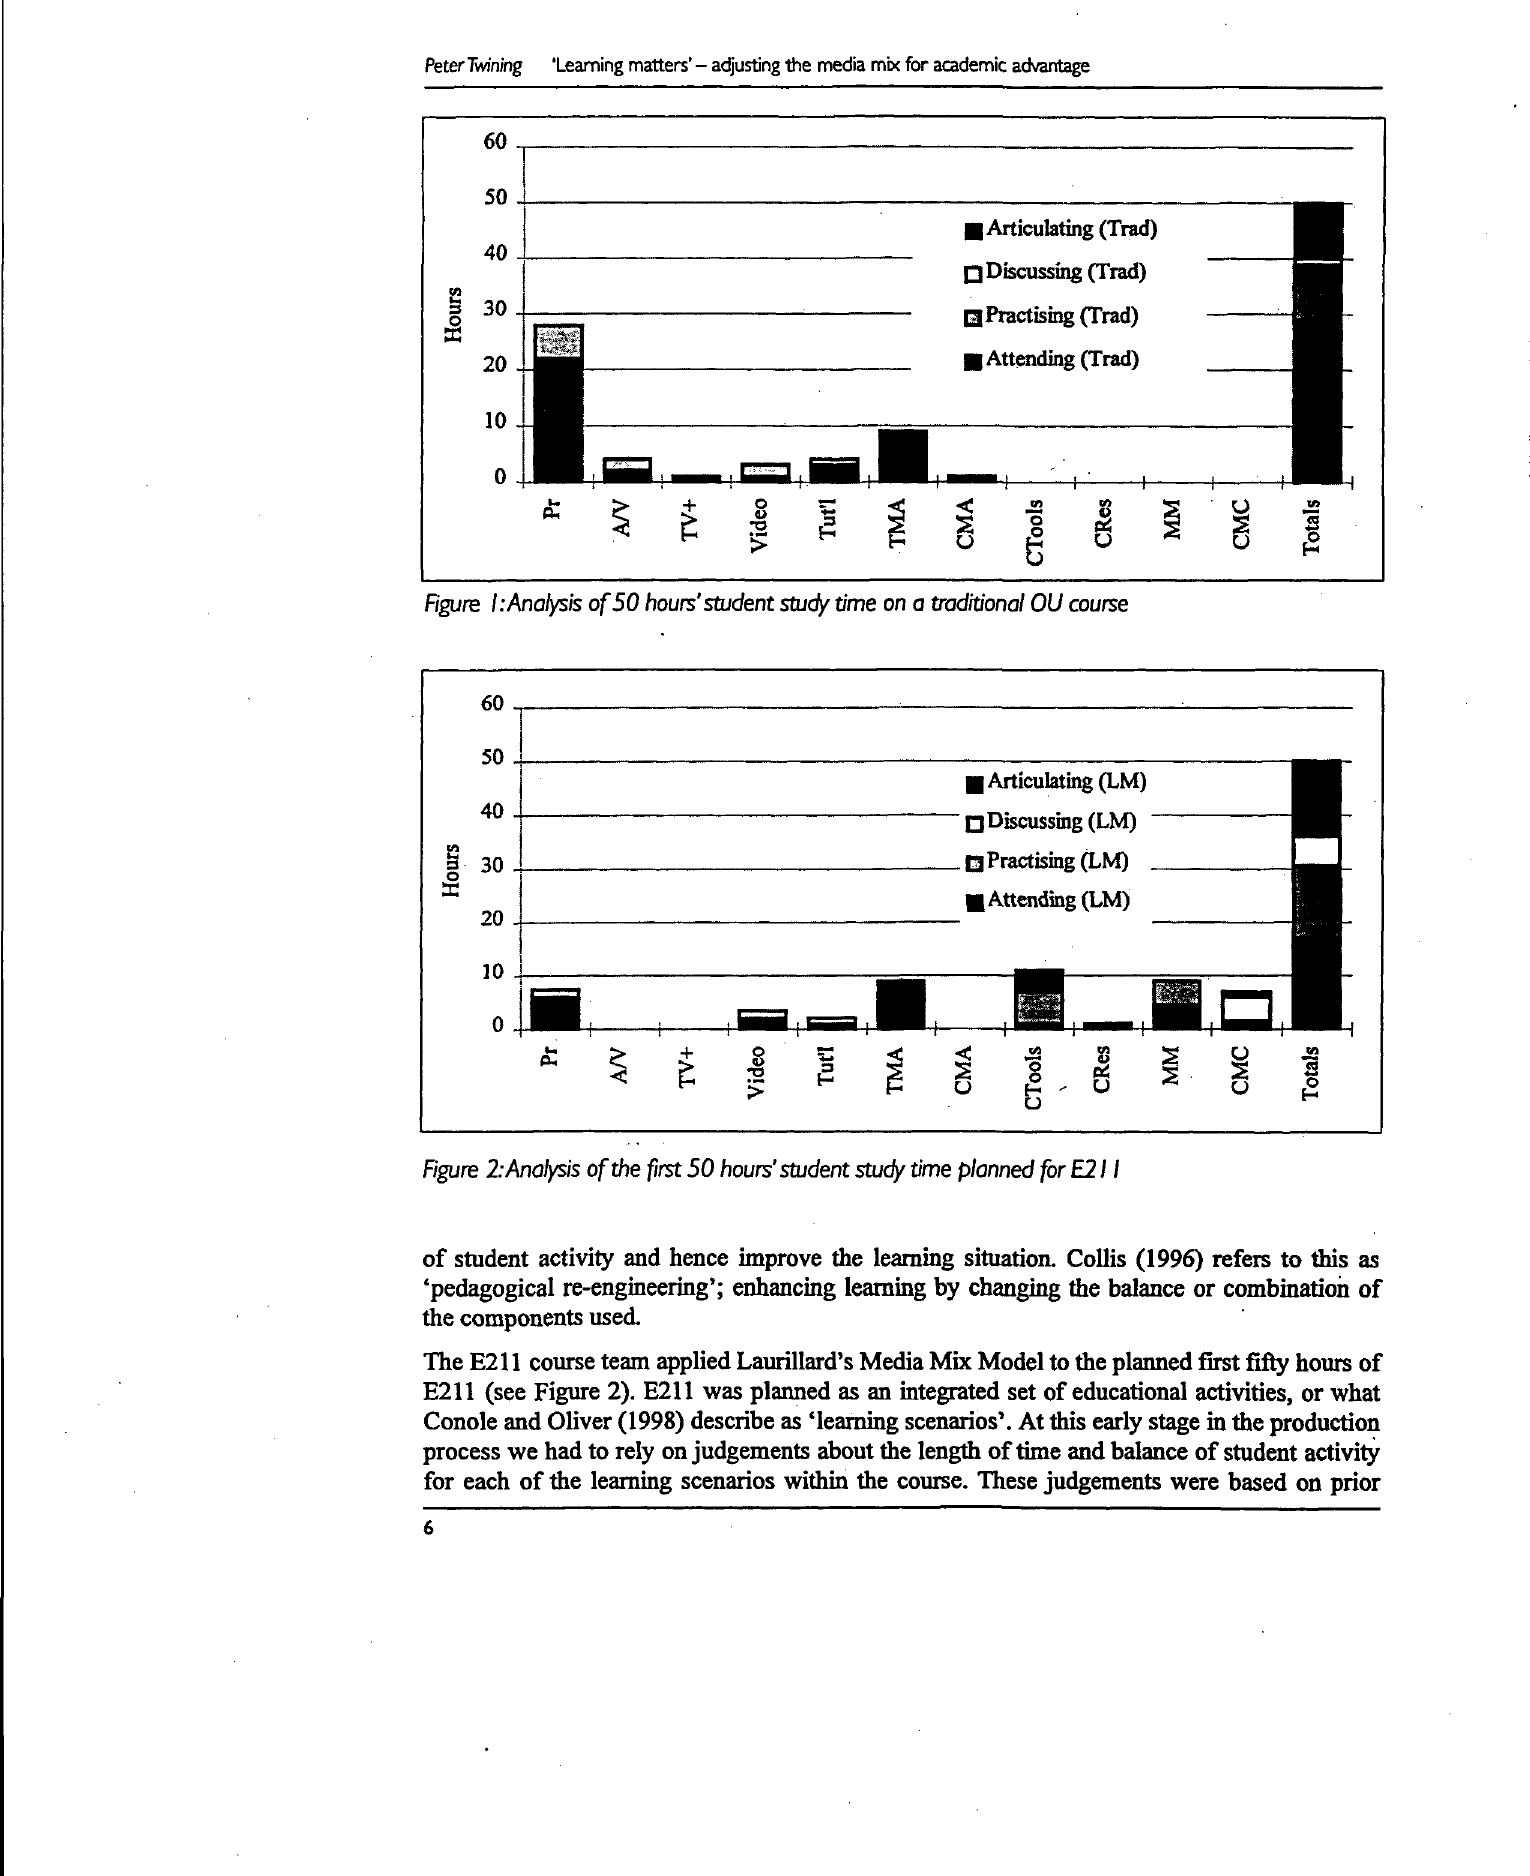
Figure I: Analysis of 50 hours'student study time on a traditional Oil course